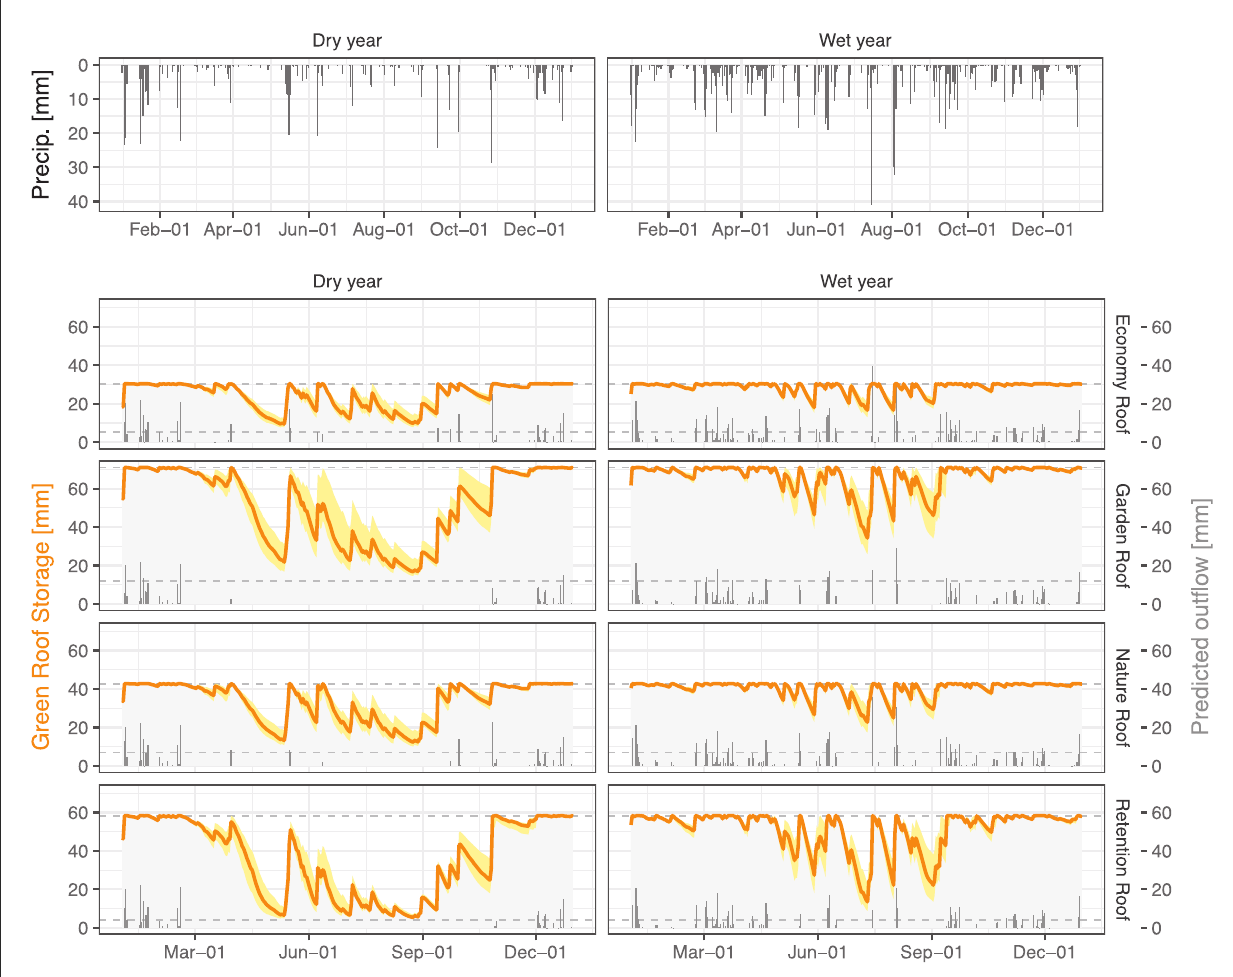
FIGURE4 Time series of GR2L water balance predictions for the extreme wet (2001) and extreme dry (2018) reference year. The upper set of panels depicts recorded precipitation from DWD station Pfullendorf. GR2L was run with calibrated parameters for each green roof type. The lower set of panels shows the model prediction over the entire year with predicted storage (yellow line with 95% confidence interval shading) and predicted outflow as gray